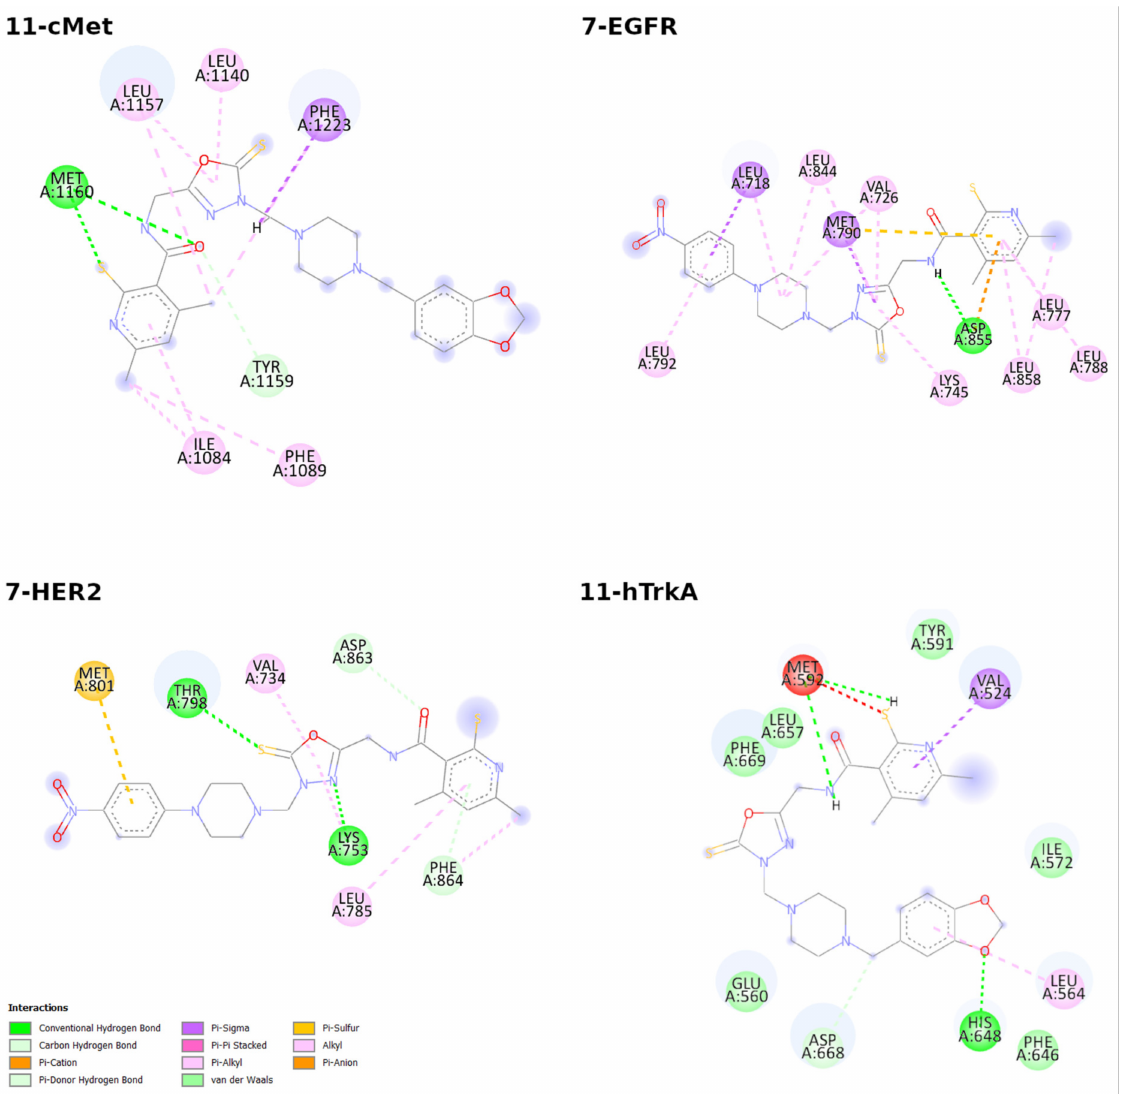
Figure 10. 2D diagrams of ligand-receptor interactions. Only the best performing ligands (compounds 7 and 11 in our case) in terms of binding affinity are